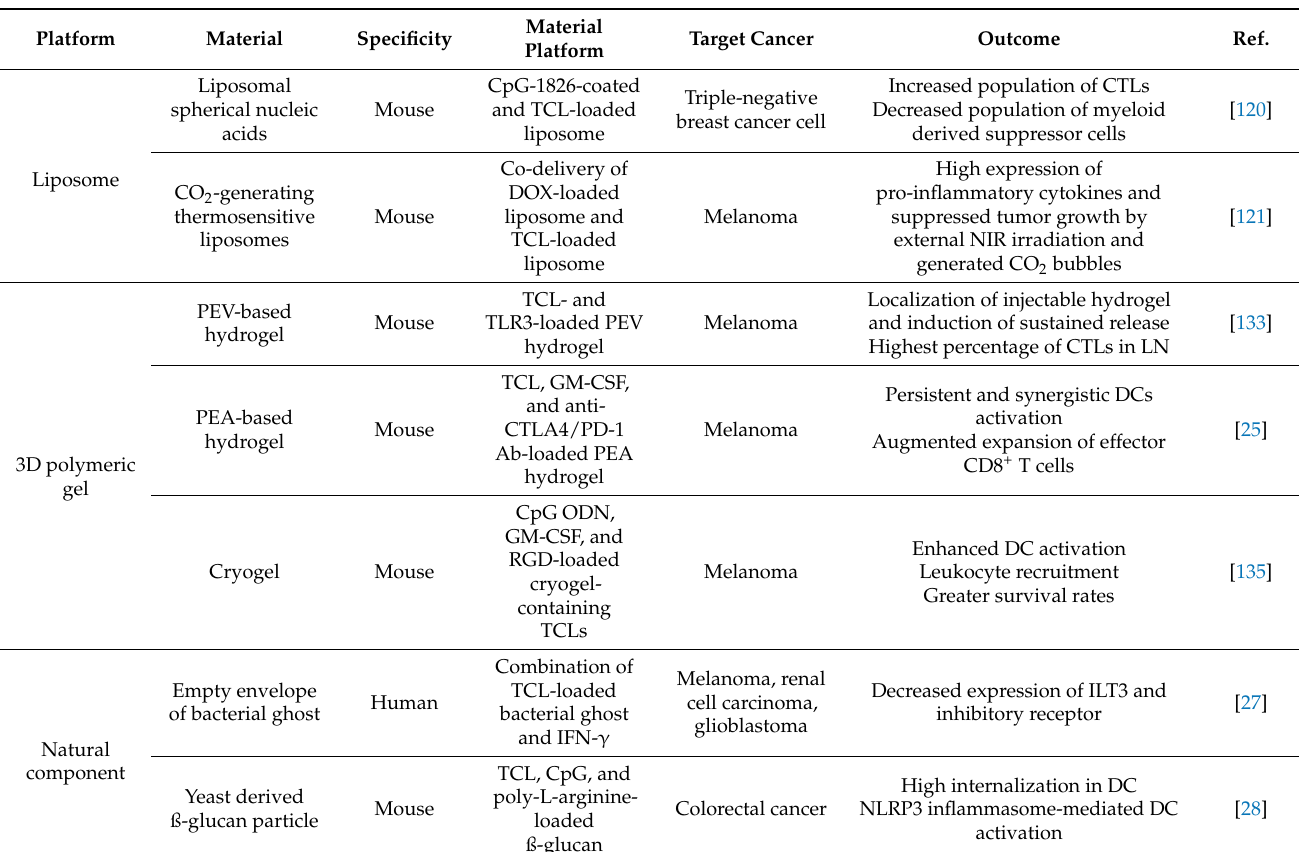
Table 3. Biomaterial-mediated whole-TCL delivery